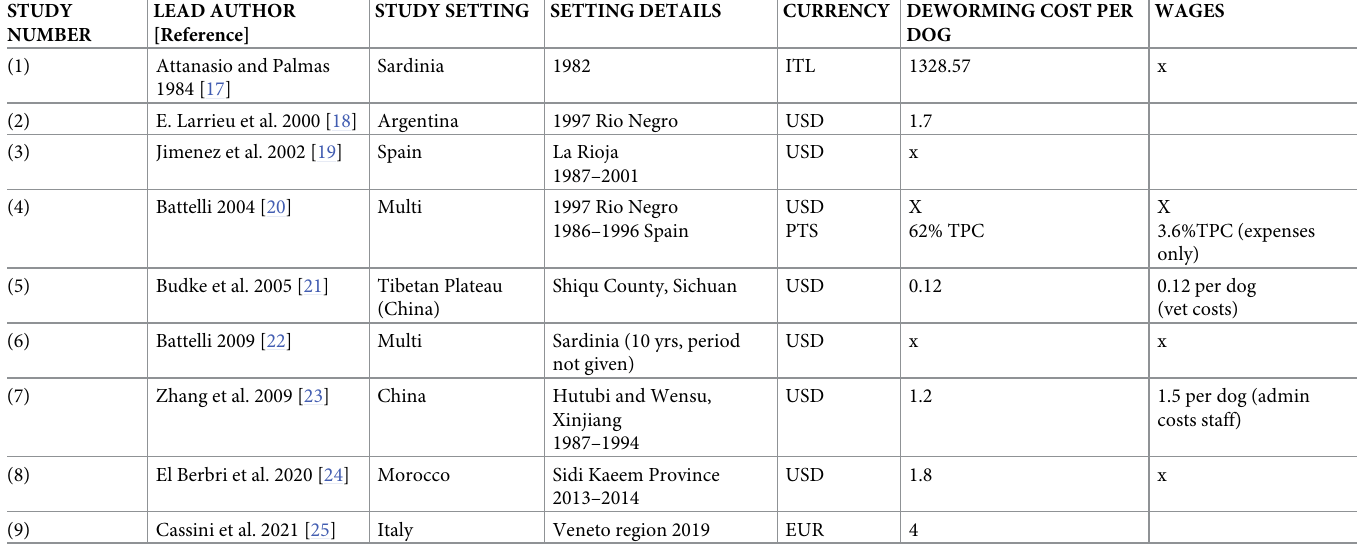
Table 3. Data extraction of the costs for the control of